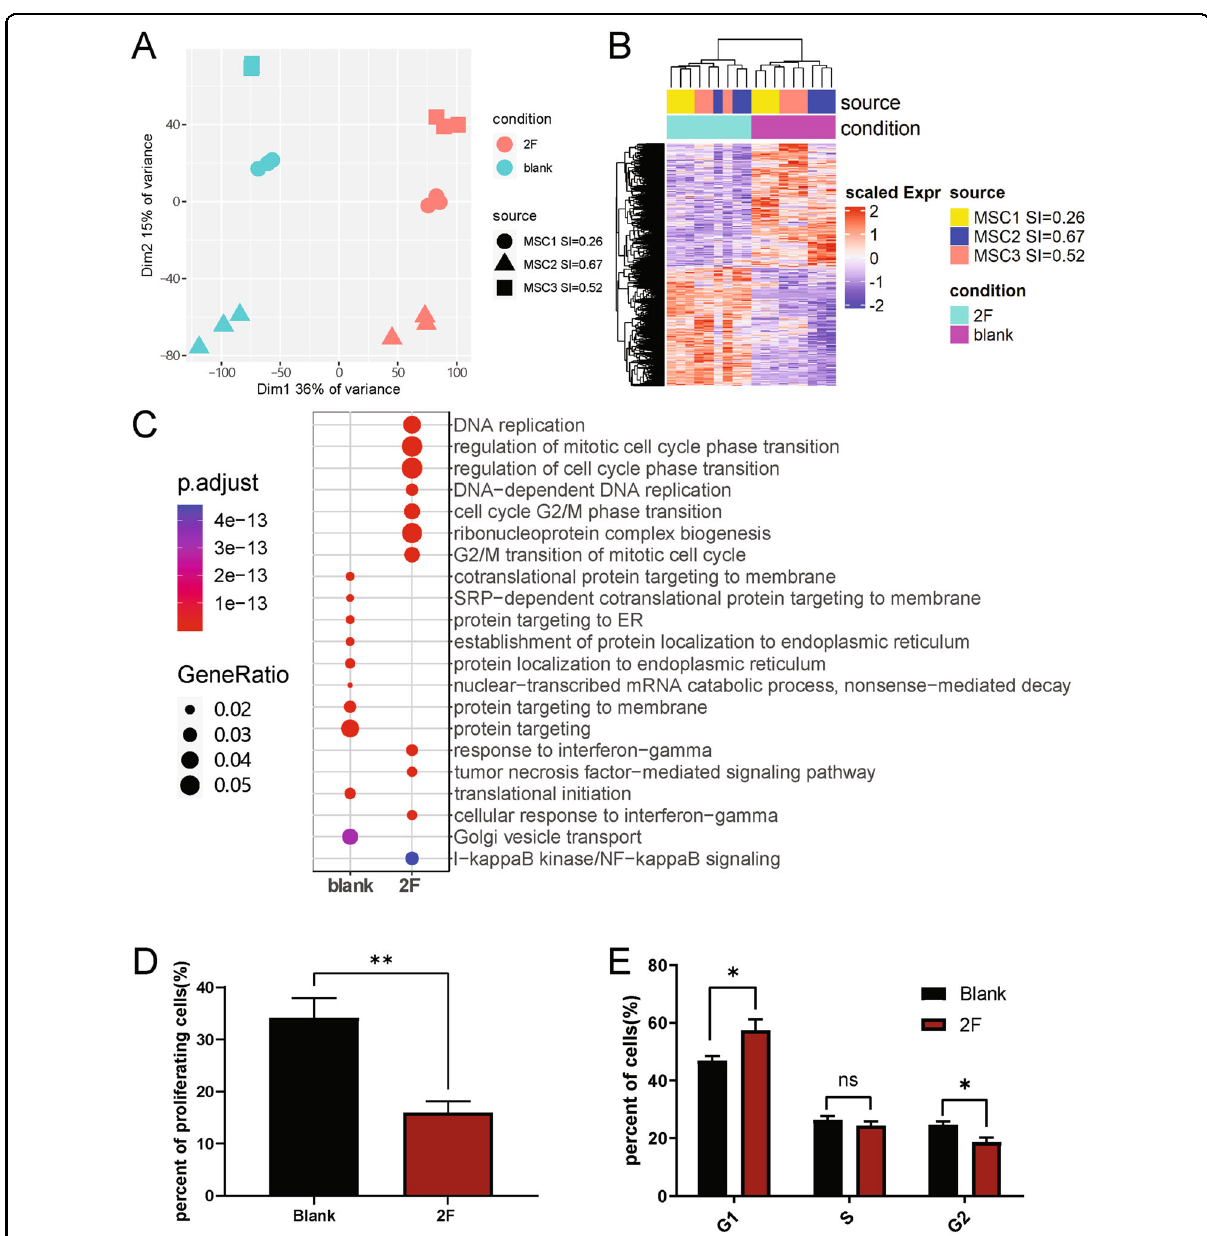
Fig. 5 Transcriptome analysis of huMSCs before and after 2-factor treatment. A PCA of all samples including 3 different genetic background and 2 conditions. B Heatmap demonstrating differentially expressed genes (DEGs) between 2 conditions. C GO enrichment analysis of DEGs in B. D Bar-plot demonstrating percentage of proliferating cells before and after 2-factor stimulation based on EdU assay. E Bar-plot shows percentage of cells in each cycle phase before and after cytokine stimulation based on fl ow